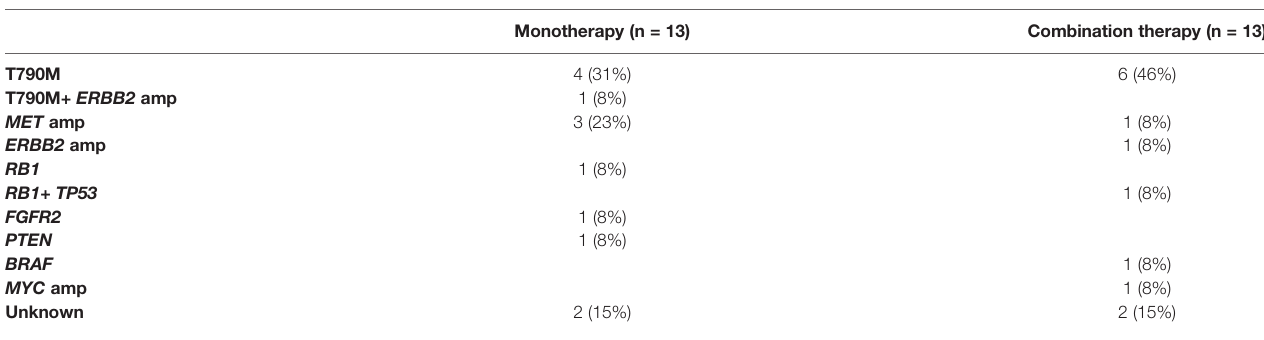
TABLE 3 | Resistance mechanism to monotherapy and combination